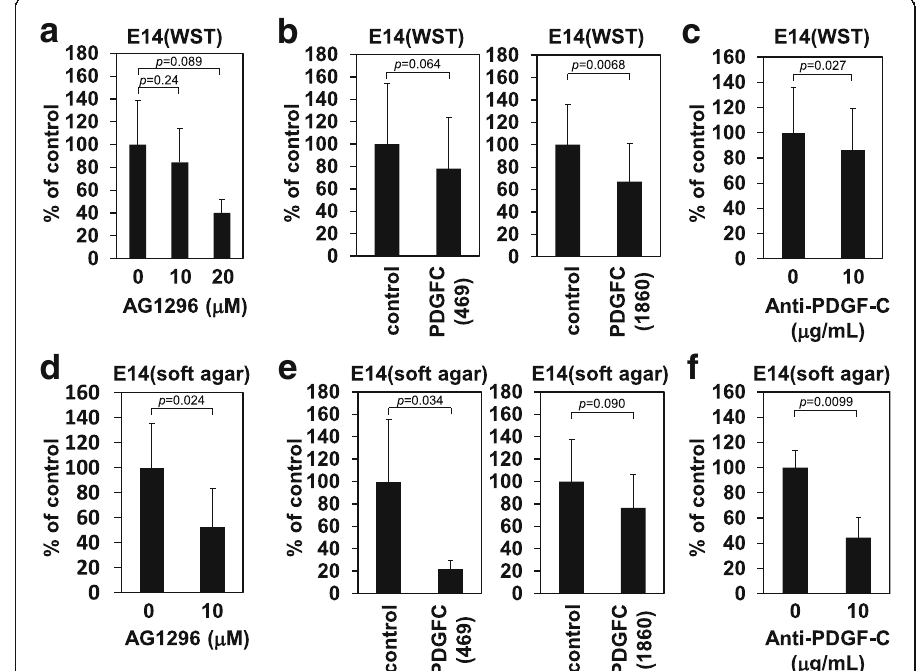
Fig. 4 PDGF-C is involved in ES cell growth. a PDGF-R inhibitor suppresses the growth of ES cells. E14 ES cells were cultured for 3 days with the indicated concentrations of AG1296 and subjected to the WST assay. b Knockdown of PDGF-C inhibits growth in ES cells. E14 ES cells were transfected with pSi-H1p-control shRNA or pSi-H1p-mPDGFC(469) (left panel) or with pCAGIP-EmGFP-control miRNA or pCAGIP-EmGFP-mPDGFC(1860) (right panel), and their growth was examined using the WST assay after 3-day culture. c Anti-PDGF-C neutralizing antibody reduces ES cell growth. E14 ES cells were cultured for 3 days in the presence or absence of 10 μ g/ml neutralizing antibody against PDGF-C and subjected to the WST assay. d Treatment with PDGF-R inhibitor decreases soft agar growth of ES cells. E14 ES cells were subjected to the soft agar assay with or without 10 μ M AG1296. e Knockdown of PDGF-C inhibits the growth of ES cells in soft agar. E14 ES cells were transfected with pSi-H1p-mPDGFC(469) (left panel) or pCAGIP-EmGFP-mPDGFC(1860) (right panel) and subjected to the soft agar assay for 1 week. f Neutralization of PDGF-C suppresses anchorage- independent growth of ES cells. E14 ES cells were subjected to the soft agar assay in the presence or absence of 10 μ g/ml PDGF-C-neutralizing antibody. In all experiments, the average result for the control samples was set to 100%. The bars and error bars represent the means and standard deviations, respectively ( n = 3, except the left panel of Fig. 4e, where n = 4). Statistical analysis was performed using two-tailed paired t test. Statistical significance is defined as p < 0.05. The raw data are shown in Additional file 1: Figure